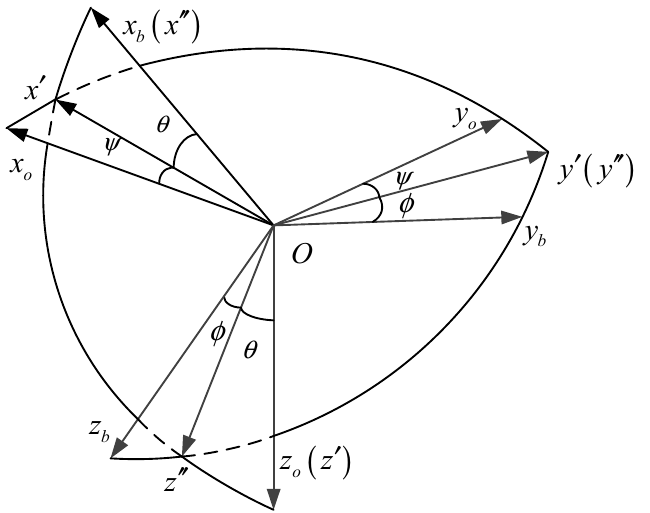
Figure 3. Coordinate frame 3-2-1 rotation.